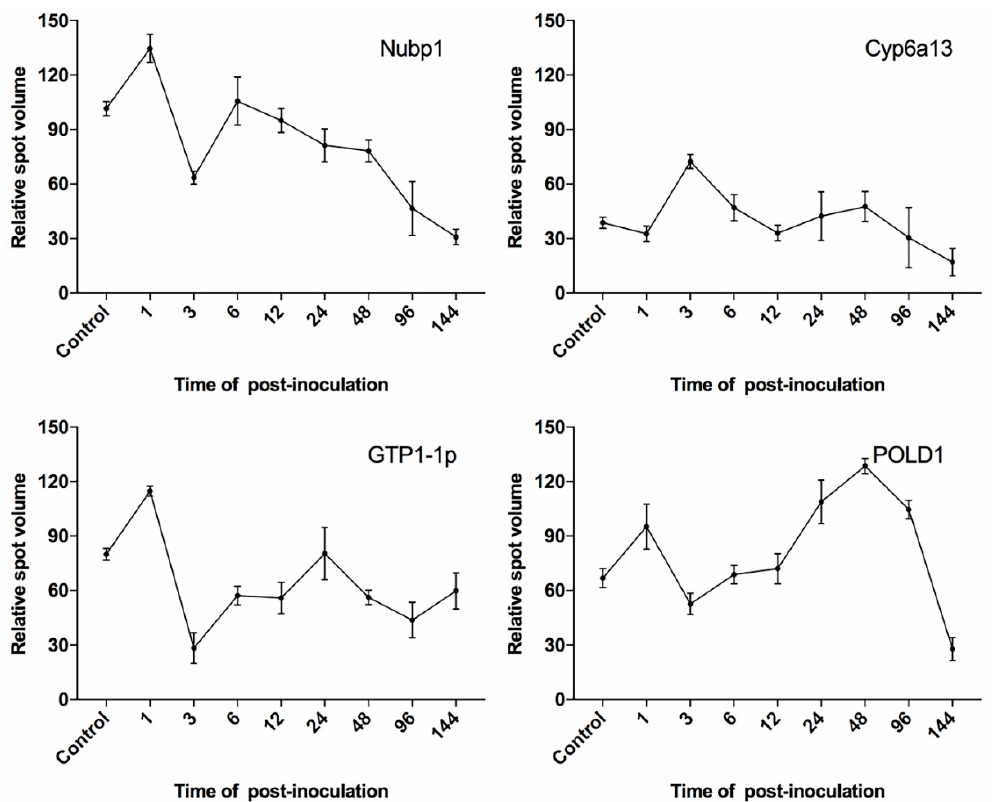
Figure 6. Protein spots of significant expression identified from Coptotermes curvignathus . X -axis: time (hours) of PI; Y-axis: mean of relative spot volume ( × 10 3 ).